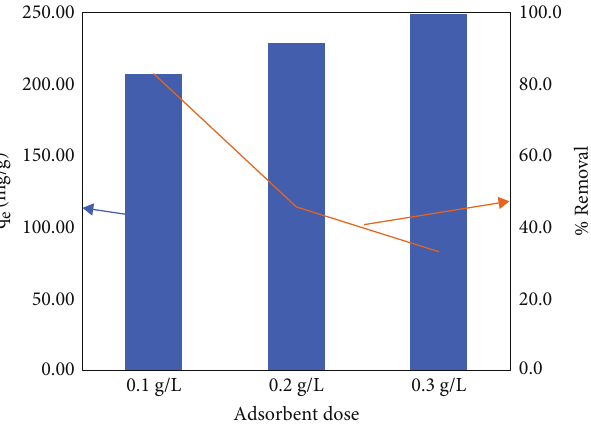
Figure 4: Adsorbent doses a ff ect MB adsorption capacity and removal